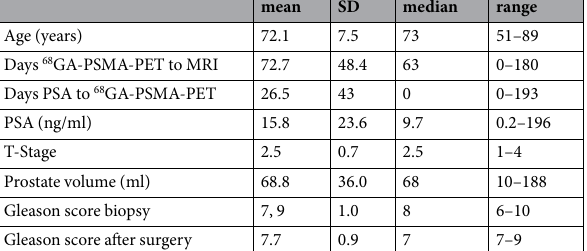
Table 5. Basic characteristics of study collective. The basic characteristics of the prostate cancer patients who received a 68 Gallium-Prostate specific membrane antigen ( 68 Ga-PSMA) PET-CT and a multiparametric MRI within 180 days investigated in this study are presented in this table. This included the age of the patients, the delay between both imaging modalities, the prostate specific antigen blood level, the delay towards the 68 Ga- PSMA PET-CT, prostate volumes, the Gleason scores from biopsy and after surgery and the tumor stages. Data are given in means, standard deviations, medians and ranges. Abbreviations: PSMA = Prostate specific membrane antigen, PET = Positron emission tomography, MRI = Magnetic resonance imaging, PSA = Prostate specific antigen blood